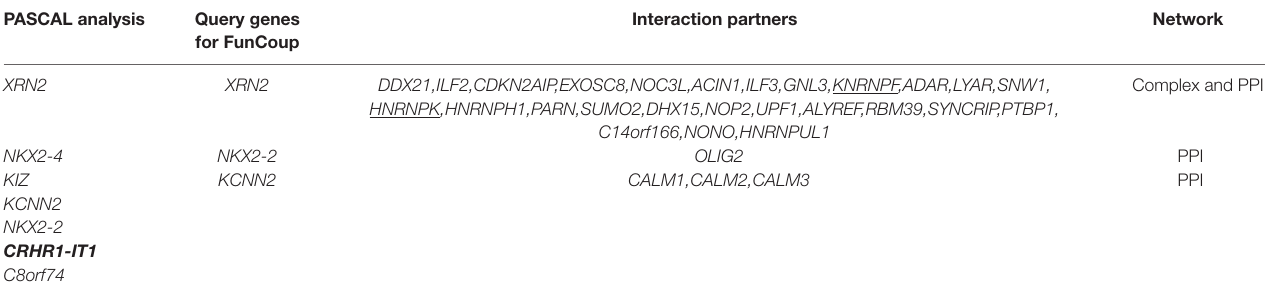
TABLE 2 | FunCoup interactors detected using PASCAL associated genes as input. Some PASCAL- associated genes have not been detected by FunCoup (bold font). Those genes for which one or several interactors were found are shown in the table. Last column indicates the type of functional coupling among genes used to construct the network. Moreover, some PASCAL- associated genes and interactors were not detected by FUMA (underlined